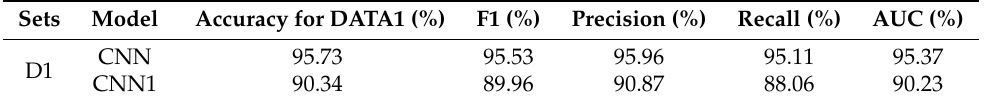
Table 5. Evaluation on D1 with CNN and CNN1.